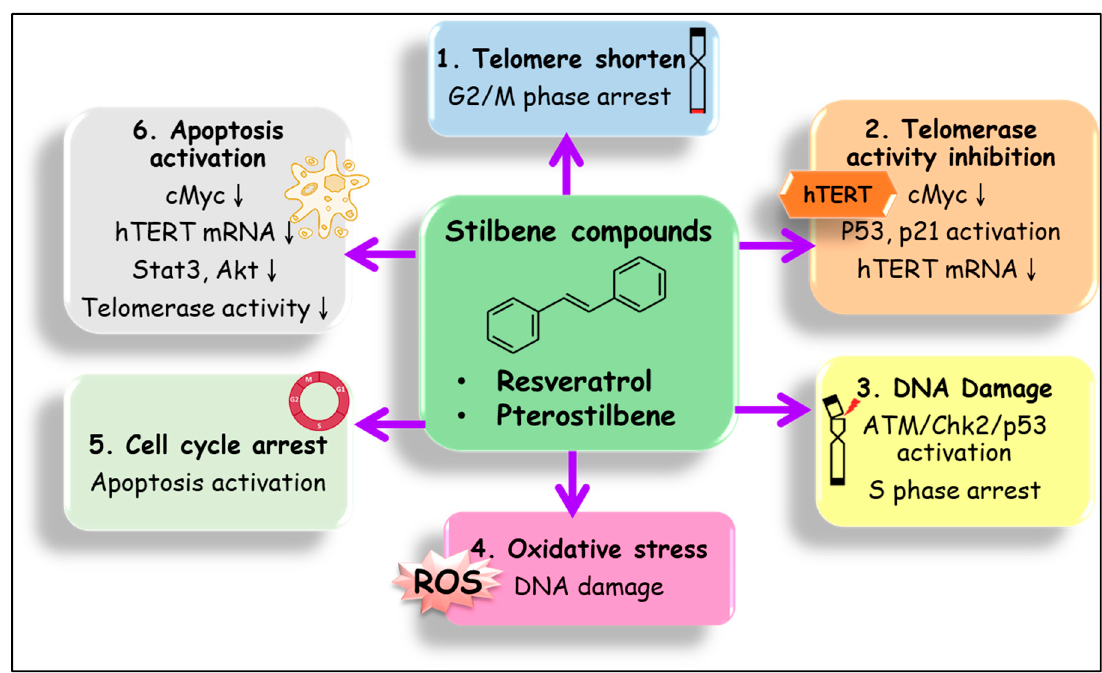
Figure 1. Anticancer mechanisms of stilbene compounds by targeting of the telomerase reverse transcriptase (hTERT) and senescence related pathways. The core structure of stilbene family is 1,2-diphenylethylene based skeleton. The derivative of stilbenes compounds such as resveratrol (RSV, 3,4 ′ ,5-trihydroxy-trans-stilbene), pterostilbene (PT, trans-3,5-dimethoxy-4-hydroxystilbene), and piceatannol (PIC, 3,4 ′ ,3 ′ ,5-trans-trihydroxystilbene), can inhibit cancer cell proliferation by inhibiting hTERT expression/activity and inducing cellular via various pathways, including ( 1 ) telomere shortening leading to G2/M arrest, ( 2 ) telomerase activity inhibition by hTERT mRNA express inhibition, p53/p21 activation and cMyc inhibition, ( 3 ) DNA damage and subsequently ataxia-telangiectasia mutated (ATM)/Chk2/p53 activation and S phase arrest, ( 4 ) cellular oxidative stress induced DNA damage, ( 5 ) cell cycle arrest and apoptosis activation, and ( 6 ) apoptosis activation by inhibition of cMyc, hTERT mRNA express, Stat3/Akt, and telomerase activity.